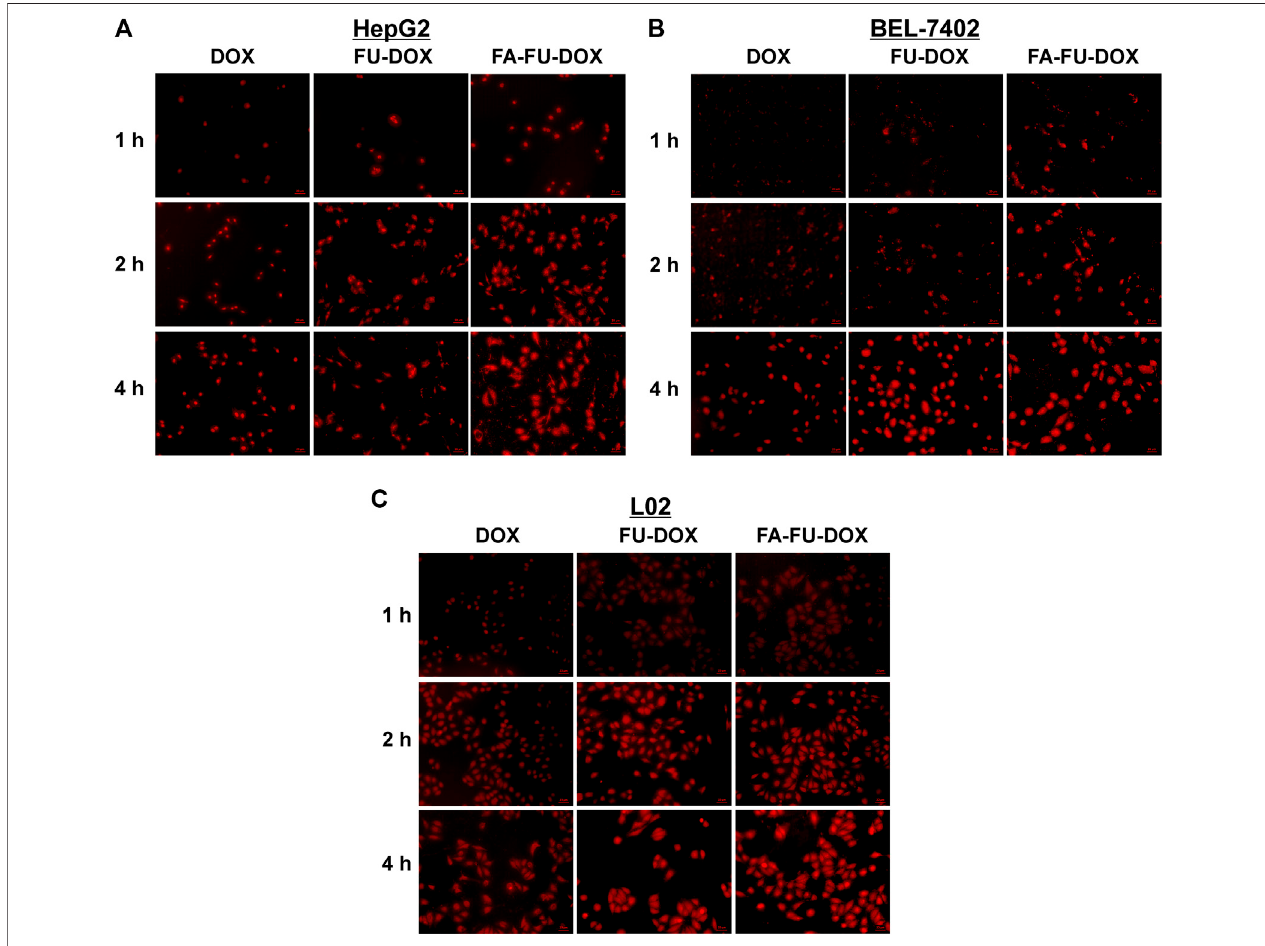
FIGURE 5 | Cellular uptake of FU-DOX and FA-FU-DOX. (A) HepG2, (B) BEL-7402, and (C) L02 cells were incubated with DOX, FU-DOX, or FA-FU-DOX for 1, 2, and 4 h, then the cellular uptake was monitored by a fl uorescent microscopy (scale bar, 20 μ m).